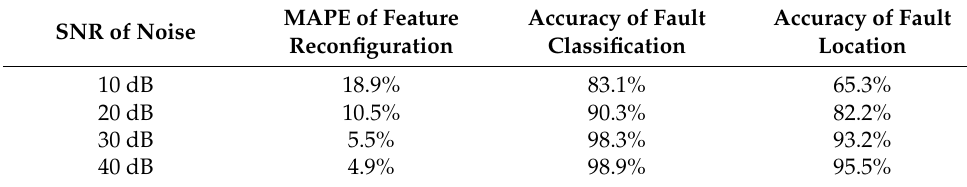
Table 4. Comparison results of different μ PMU allocations.